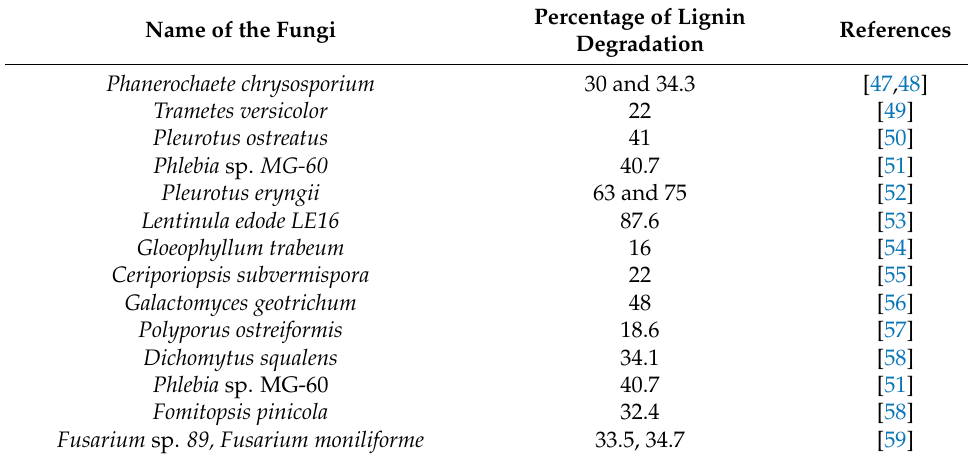
Table 3. List of fungal strains with their potential to degrade